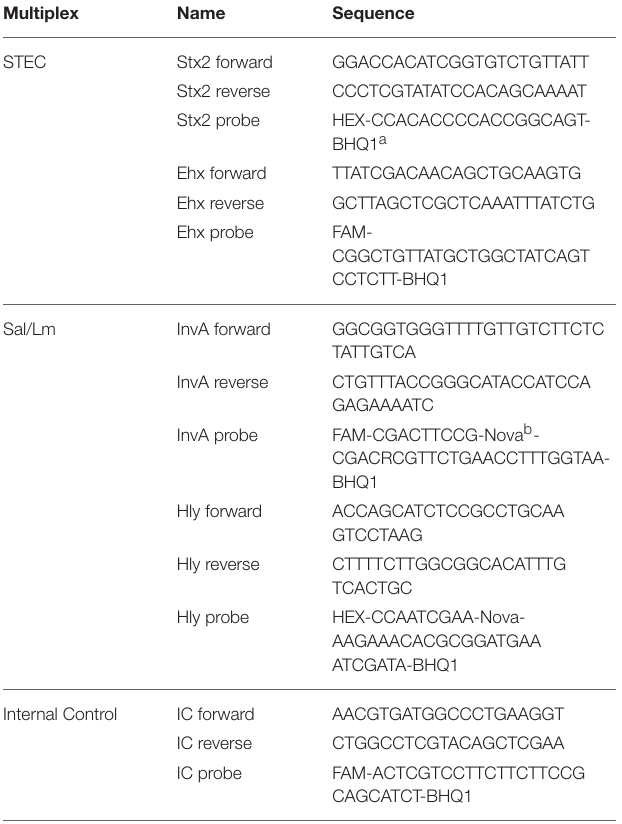
TABLE 1 | Primers and